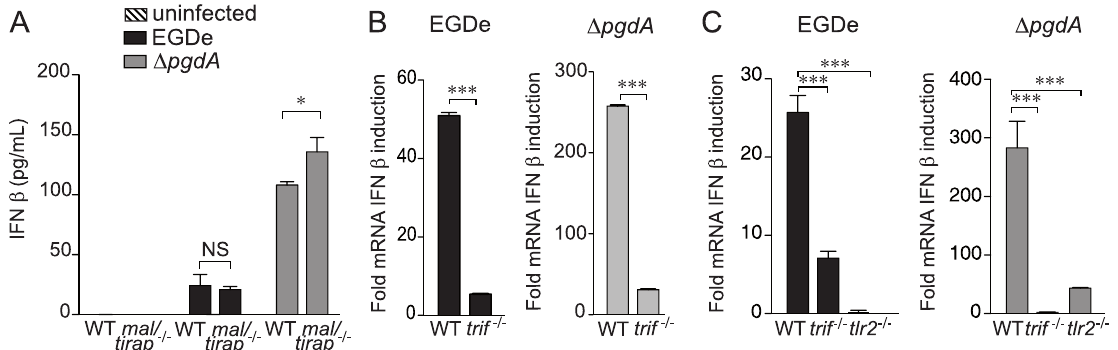
Figure 3. TRIF, but not Mal/TIRAP, is necessary for IFN- b response to Listeria in peritoneal macrophages. (A) PEM from WT C57BL/6J or mal/tirap 2 / 2 mice were infected with the parental EGDe strain (black bars), the D pgdA mutant (grey bars). After 7 h of infection, IFN- b levels were measured in supernatants by ELISA. (B) PEM from C57BL/6J or trif 2 / 2 mice were infected with the parental EGDe strain (black bars) or the D pgdA mutant (grey bars). After 4 h of infection, IFN- b induction was measured by qRT-PCR. (C) Resident peritoneal macrophages from WT C57BL/6J, trif 2 / 2 or tlr2 2 / 2 mice were infected with the parental EGDe strain (black bars), the D pgdA mutant (grey bars). After 4 h of infection, IFN- b induction was measured by qRT-PCR. Data are mean 6 SD (NS, non significant; *, p , 0.05; ***, p , 0.0001; n =3–4).